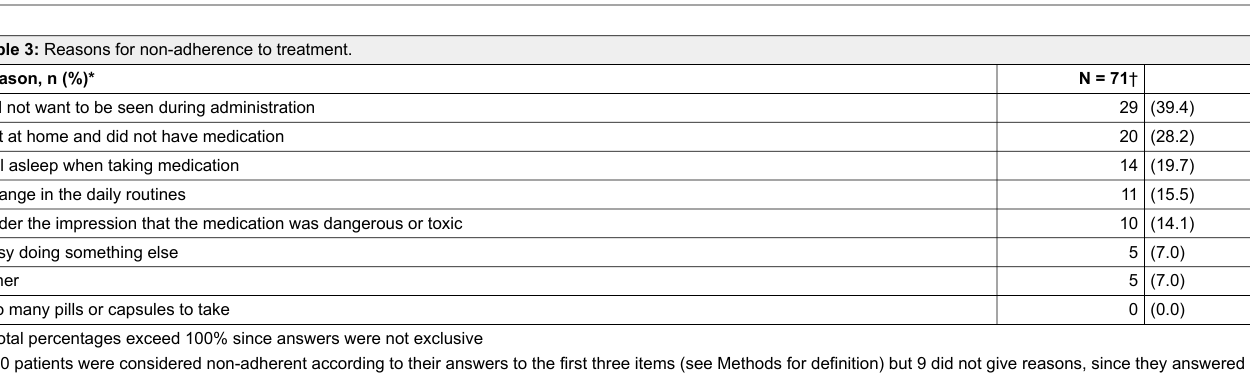
Table 3: Reasons for non-adherence to treatment. Reason, n